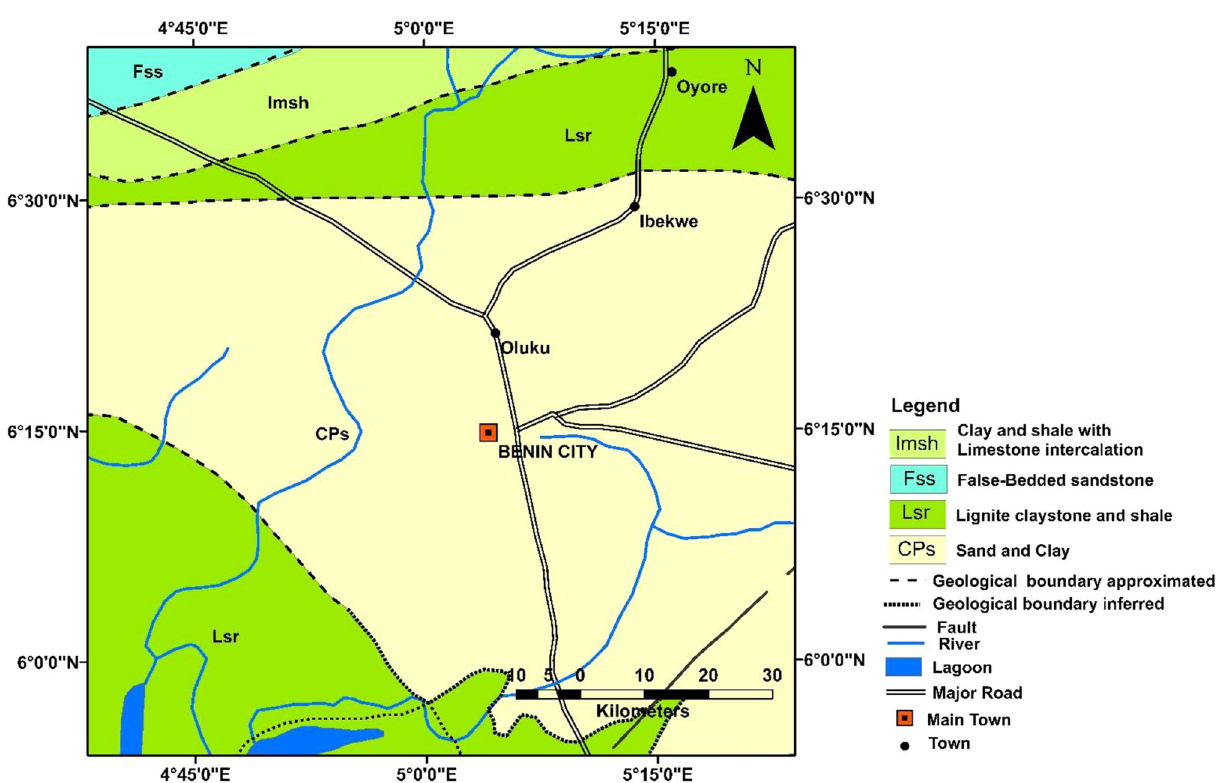
Fig. 2 Geologic Map of Benin area